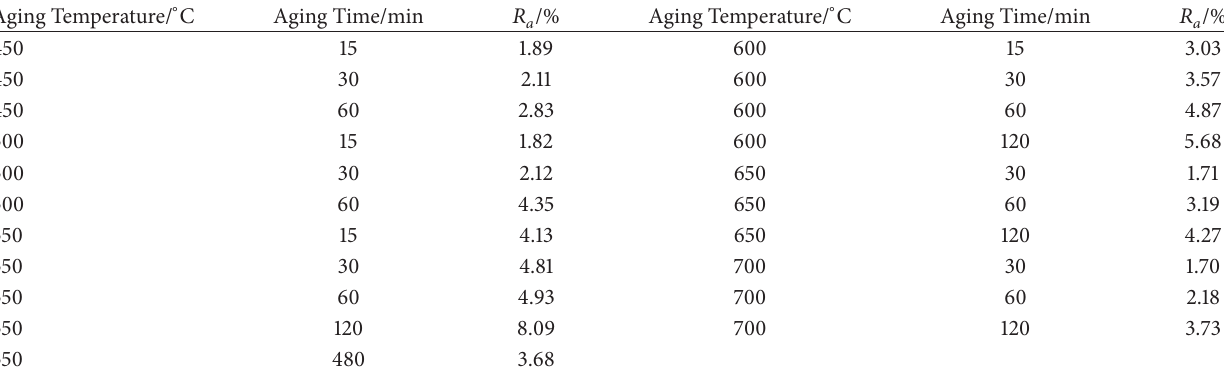
Table 3: 𝑅 𝑎 values of FSS 429 for different aging treatments.